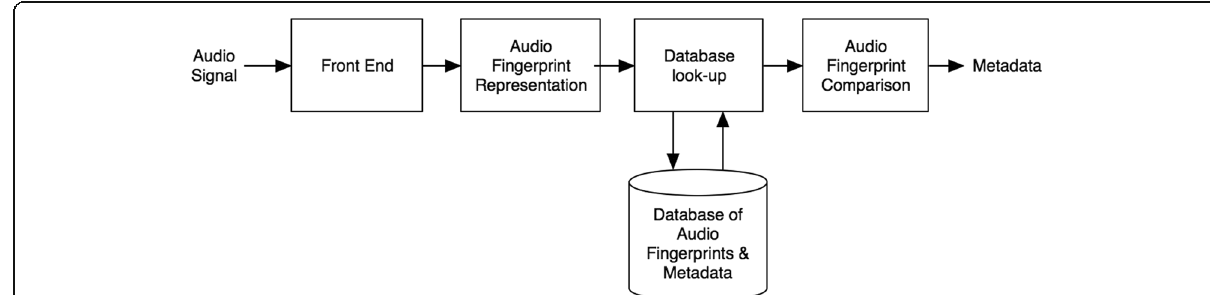
Fig. 1 Audio fingerprint system. This figure shows the general audio fingerprinting system done by previous authors. The algorithms generally followed this approach where the raw audio would be captured (by loading the audio signal or by microphone). The audio signal is then processed into a digital format where the audio fingerprints are extracted. The audio fingerprints of songs that were similarly processed and stored in a database are then compared by some algorithm to execute a database lookup. After the resulting audio fingerprint comparison is done, the corresponding song information for the highest match is